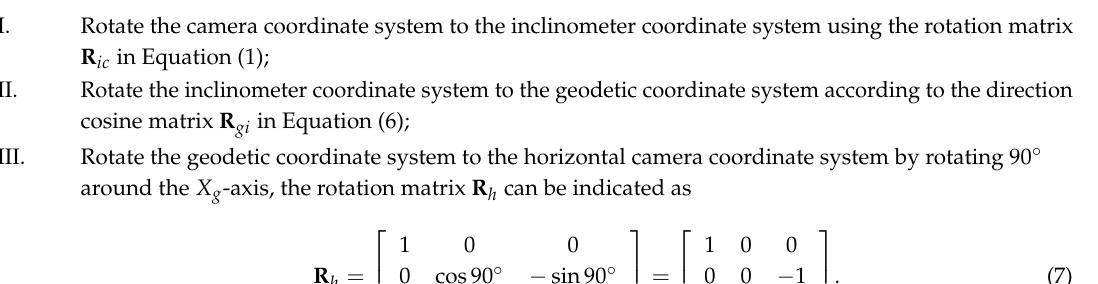
Algorithm 1: Horizontal image correction using the inclinometer.